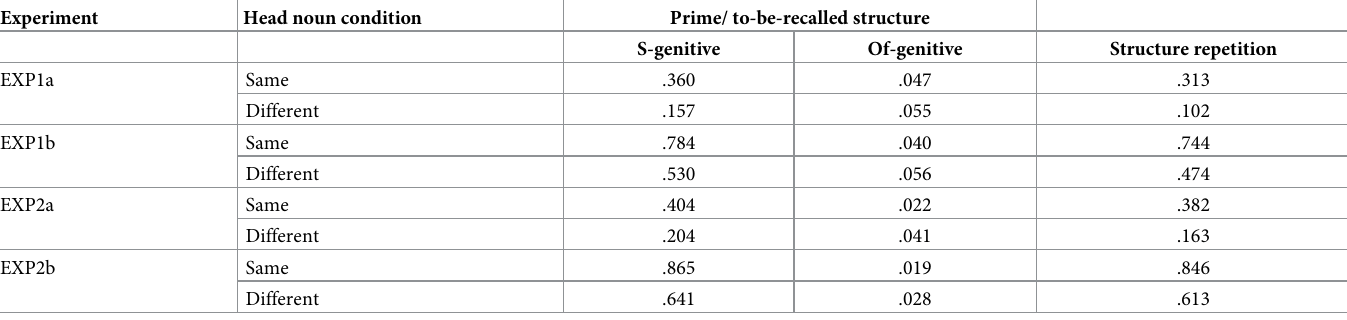
Table 1. Proportions of s-genitive responses out of all the s-genitive and of-genitive responses for each prime condition � head noun condition combination in each experiment. Experiment